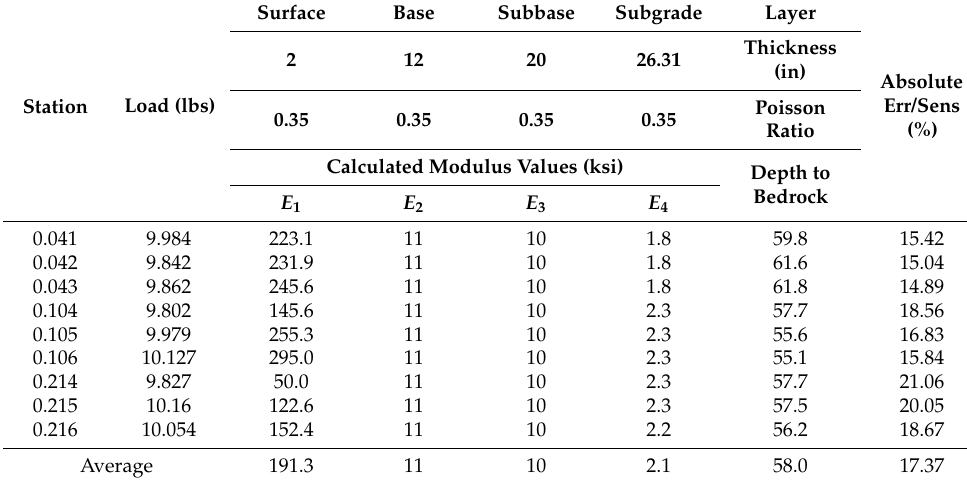
Table 2. Elastic modulus back-calculation results for the unreinforced pavement in the program.